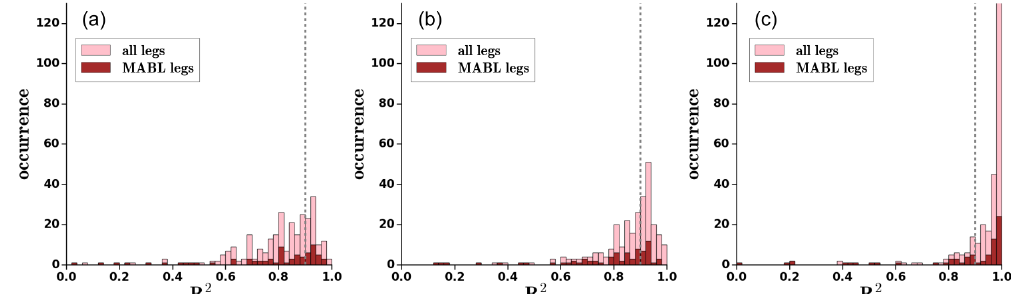
Figure 4. Histograms of the linear regression R-squared value ( R 2 ) associated with the calibration of the KH20 fast humidity measurement with, as the reference slow measurement, (a) the 1011C mirror hygrometer, (b) the WVSS2 sensor and (c) the WVSS2 sensor phased in time with the fast sensor. The comparison is done for all flights from RF11 to RF19, considering either the entire set of legs or just the legs flown within the MABL. The vertical dashed line represents the R 2 = 0 . 9 threshold.